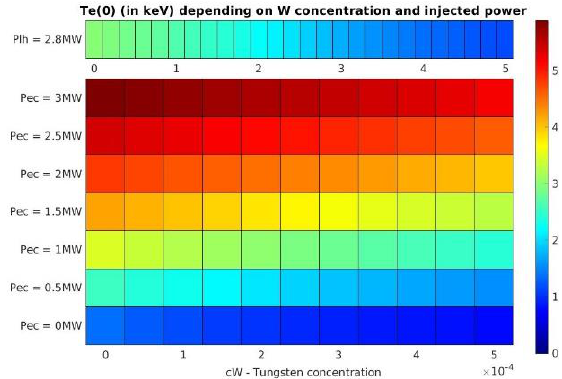
Figure 10: Central electron temperature as a colour map depending on the injected power and the tungsten